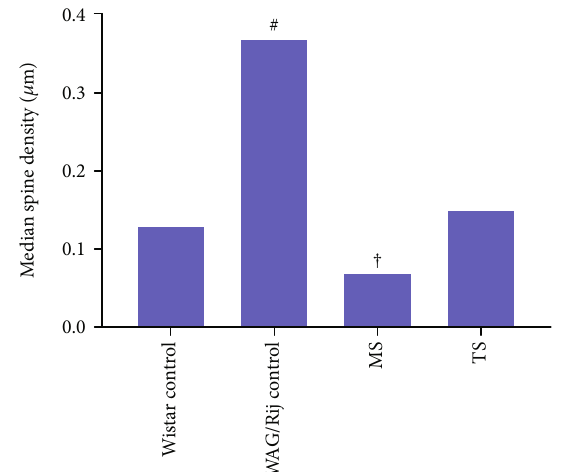
Figure 3: Median spine density in layer V pyramidal neurons of control Wistar ( n = 6 ), control WAG/Rij ( n = 6 ), maternally separated WAG/Rij ( n = 6 ), and tactile-stimulated WAG/Rij rats ( n = 6 ). # p < 0 : 001 , WAG/Rij control compared to other groups and † p < 0 : 001 , MS compared to other groups (Kruskal Wallis